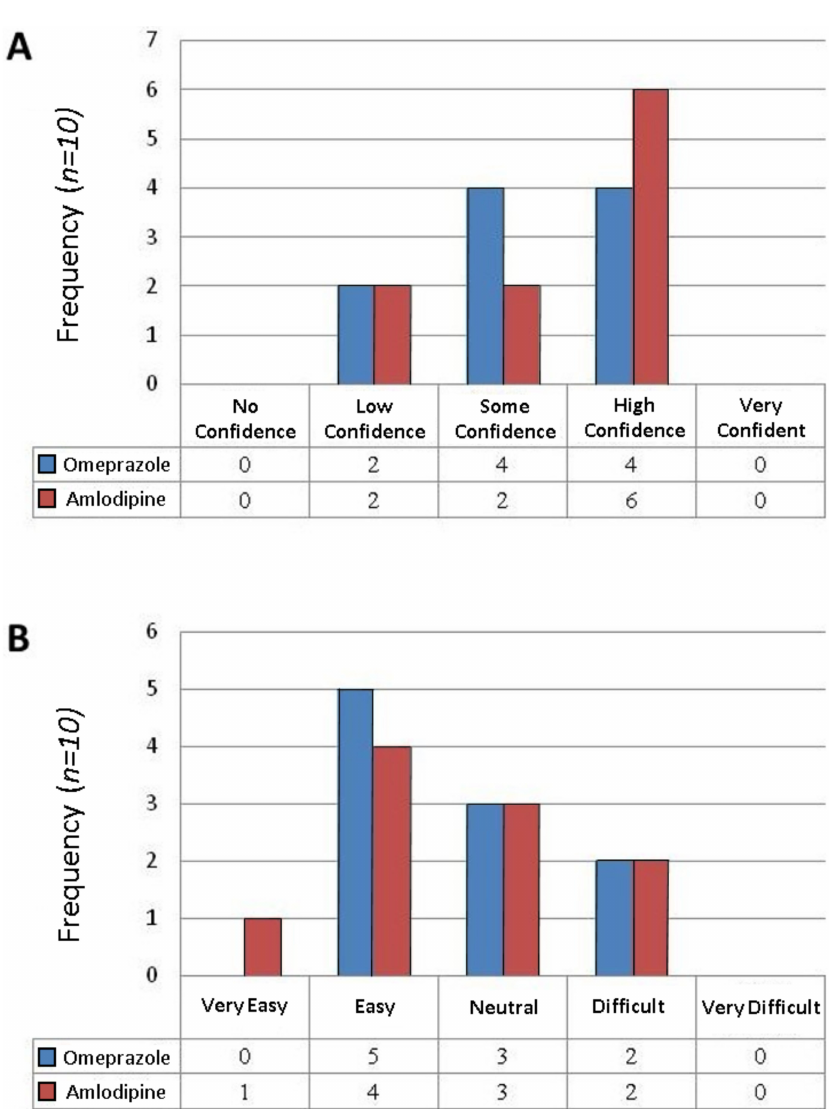
Figure 2. A bar chart showing pharmacists’ level of confidence in the final preparation of omeprazole and amlodipine ( A ) and the level of complexity preparing the product ( B ). Table 4. Statistical analysis of survey results. Wilcoxon Signed Rank Test was used to compare the medians between the two formulations. Questions on confidence were on a scale of 1–5, where 1 = no confidence to 5 = very confident. Questions on the complexity of preparing the product were on a scale of 1–5, where 1 = very easy and 5 = very di ffi cult. IQR: interquartile range. Overall level of confidence extemporaneously preparing the omeprazole